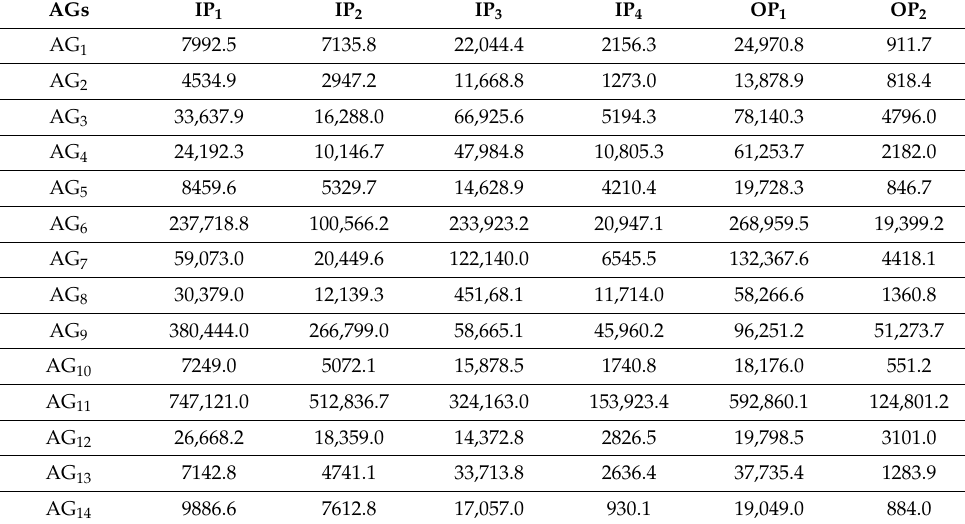
Table 4. Data in 2016 (Unit: 1000 USD).